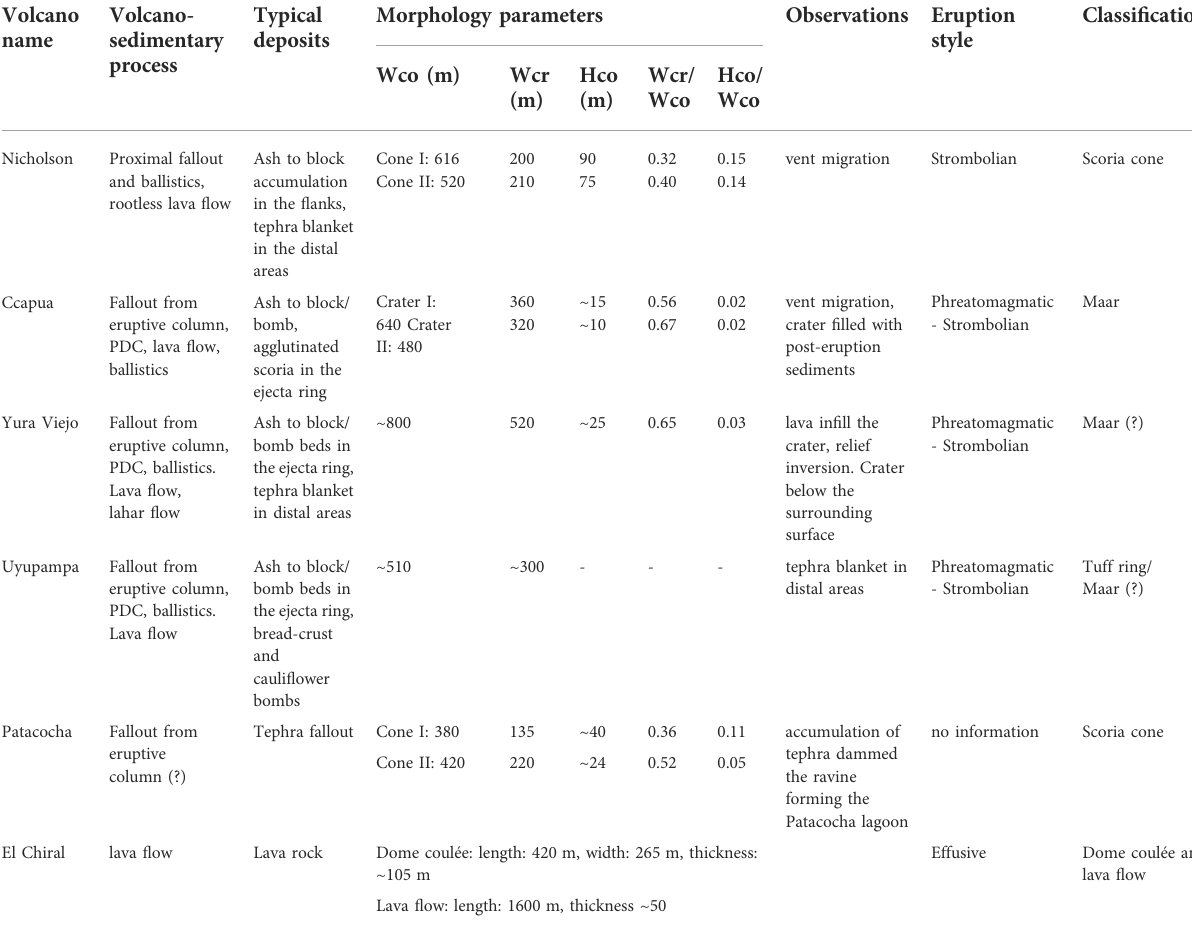
TABLE 5 Summary of characteristics and morphologic parameter for volcanic centers in the Yura Monogenetic